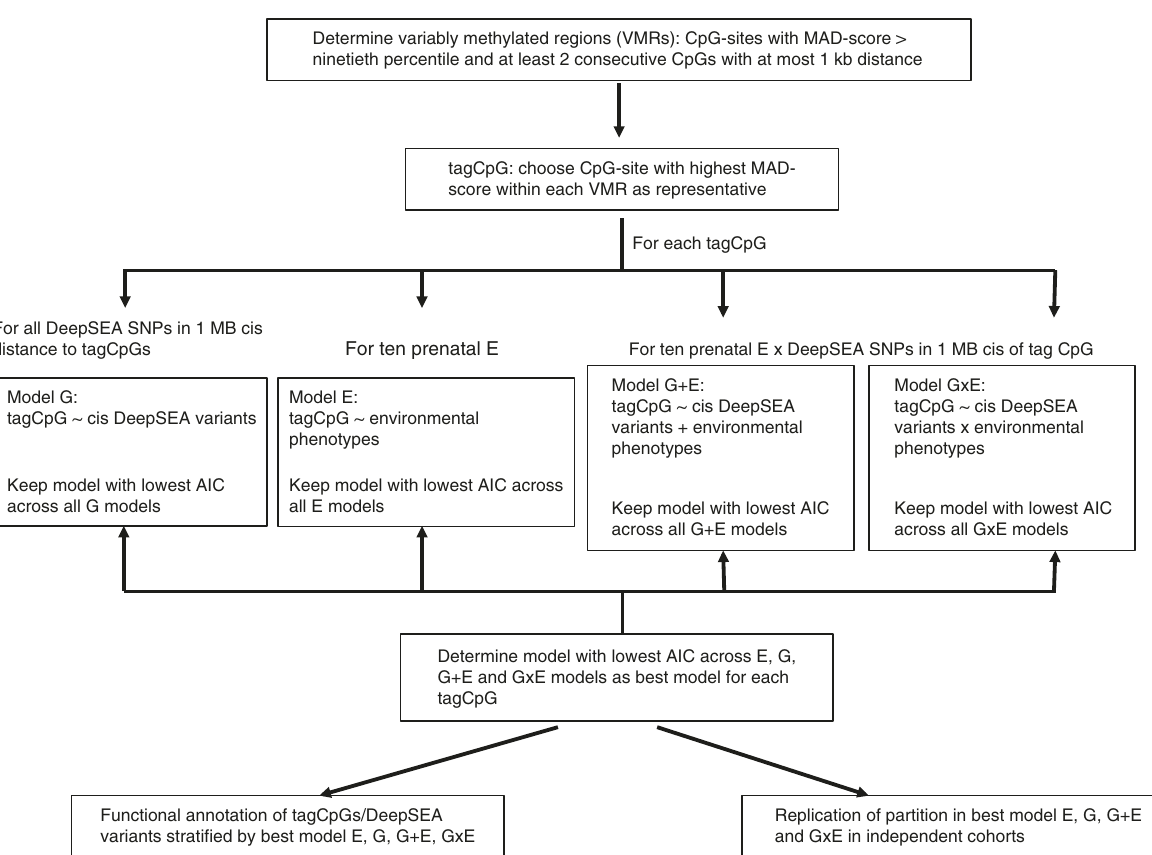
Fig. 1 Flow diagram of VMR